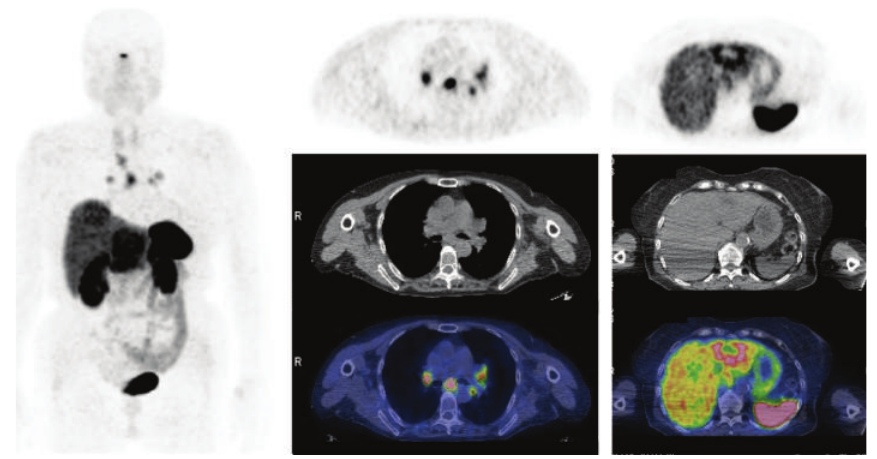
Figure 9: 68 Ga-DOTATOC PET/CT images (MIP, axial) in a patient with metastatic breast